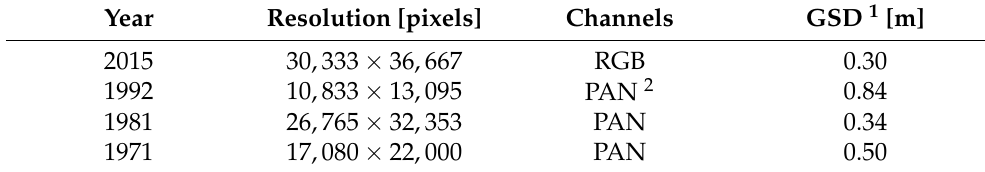
Table 2. Properties of the Sagalassos